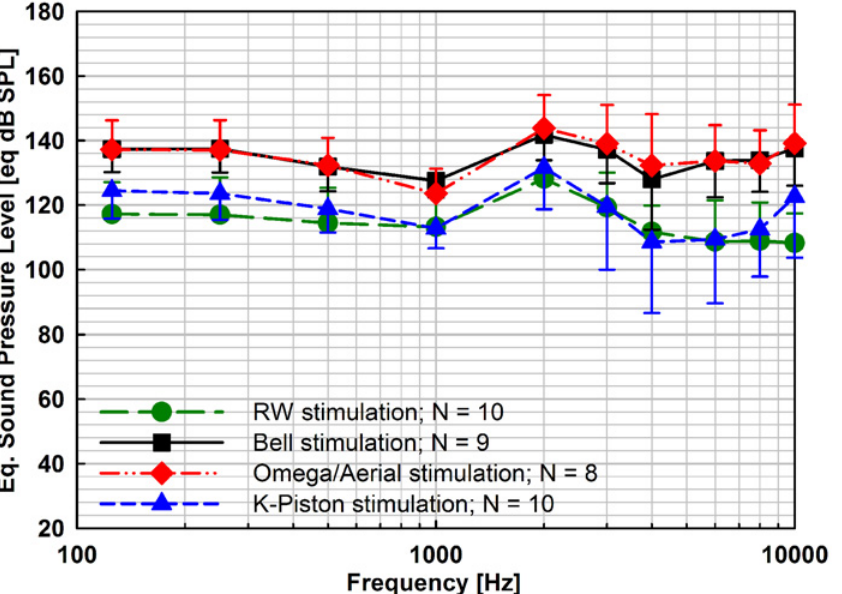
Fig 9. Mean values and standard deviations (error bars) of the equivalent sound pressure levels [eq. dB SPL] generated by Codacs actuator stimulation at 1 V rms for the four investigated stimulation modes. At all frequencies the stimulation efficiency of Bell prosthesis stimulation at the stapes head ( ■ ) and of Omega/Aerial prosthesis stimulation at the SFP ( ♦ ) was statistically significantly higher than direct perilymph stimulation ( ▲ ) with the K-piston and direct RW stimulation ( ●